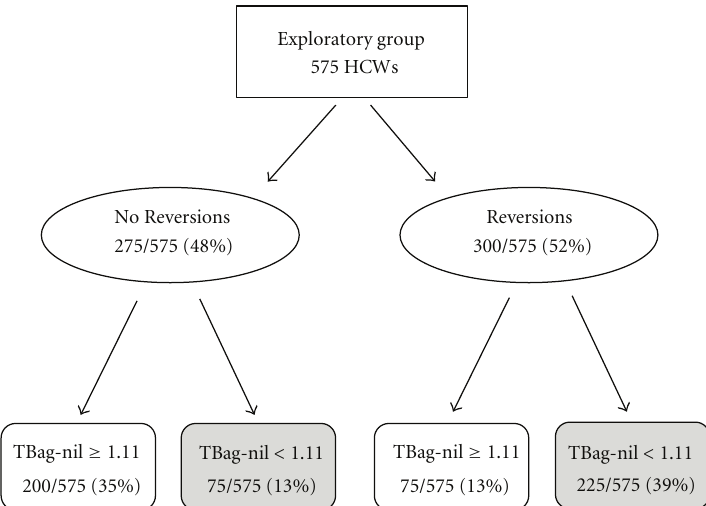
Figure 2: Exploratory group with 575 HCWs classified as No Reversions (those with two positive tests) or Reversions (with a positive TB test result at time one and who retest negative at time two). The two groups are further classified by TBag-nil values using the ROC selected separation point of 1.11 IU/mL (Kappa = 0.48, chi-square = 131.0, P < 0 . 001). Highlighted boxes emphasize the di ff erence in number of No Reversions versus Reversions when TBag-nil < 1.11IU/mL, the identified retesting zone.